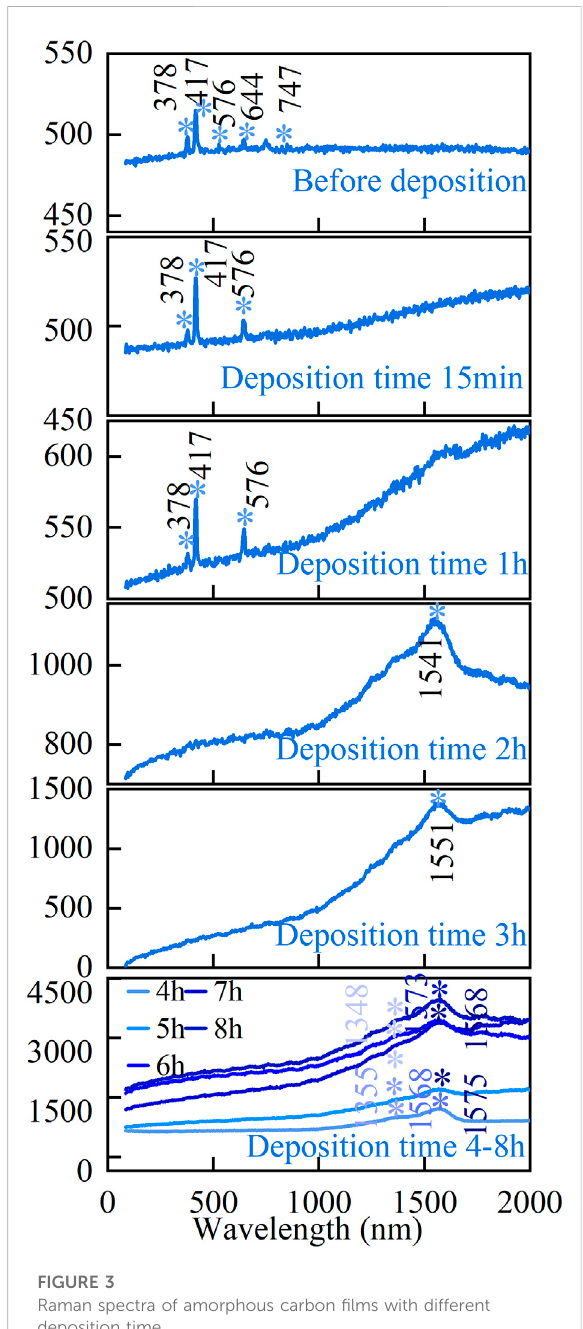
FIGURE 3 Raman spectra of amorphous carbon fi lms with different deposition